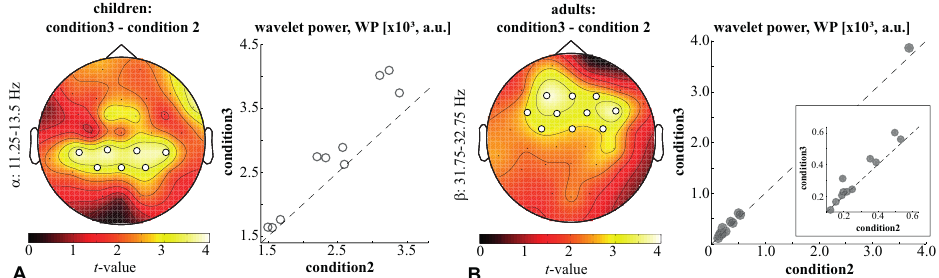
Figure 4. Significant clusters reflect the change of the children’s α -band WP ( A ) and the adults’ β -band WP ( B ) between condition3 and condition2 . Topograms illustrate t -values, and scatterplots show the pairwise differences of the WP in these clusters between conditions. The frequency ranges determine the positions of the clusters in the frequency domain.